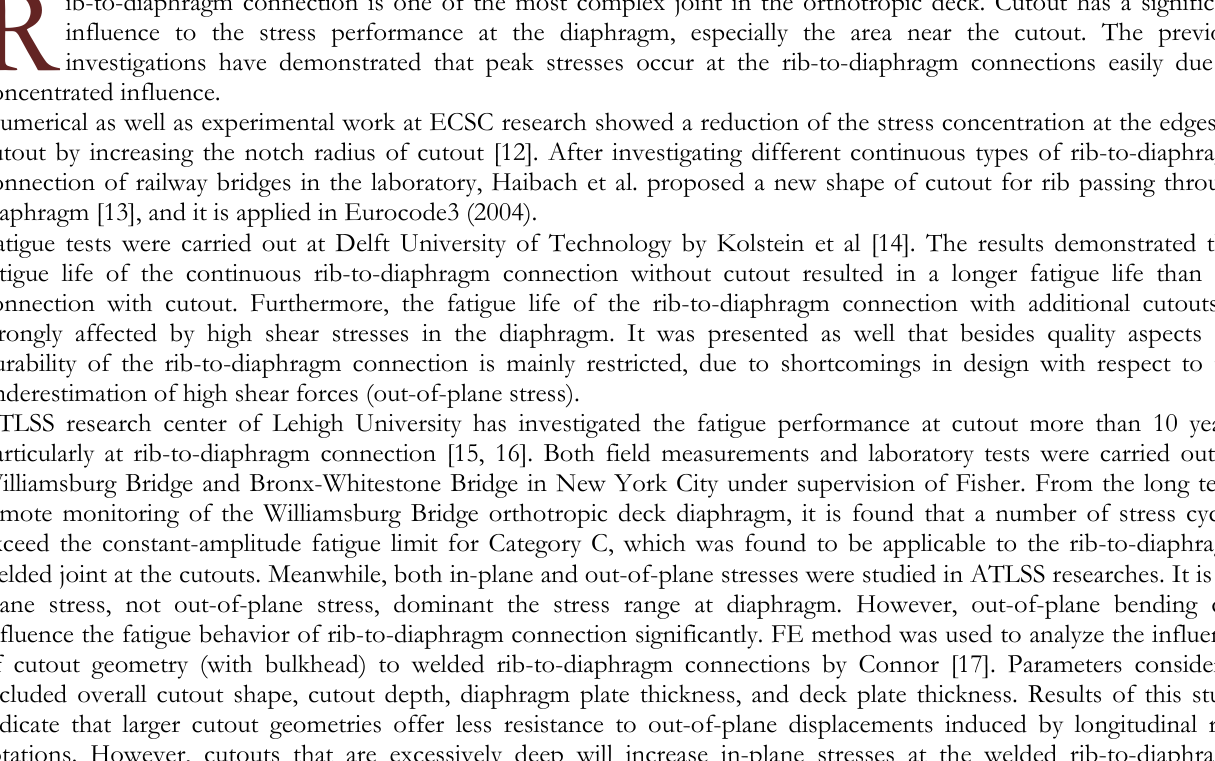
R IB - TO - DIAPHRAGM